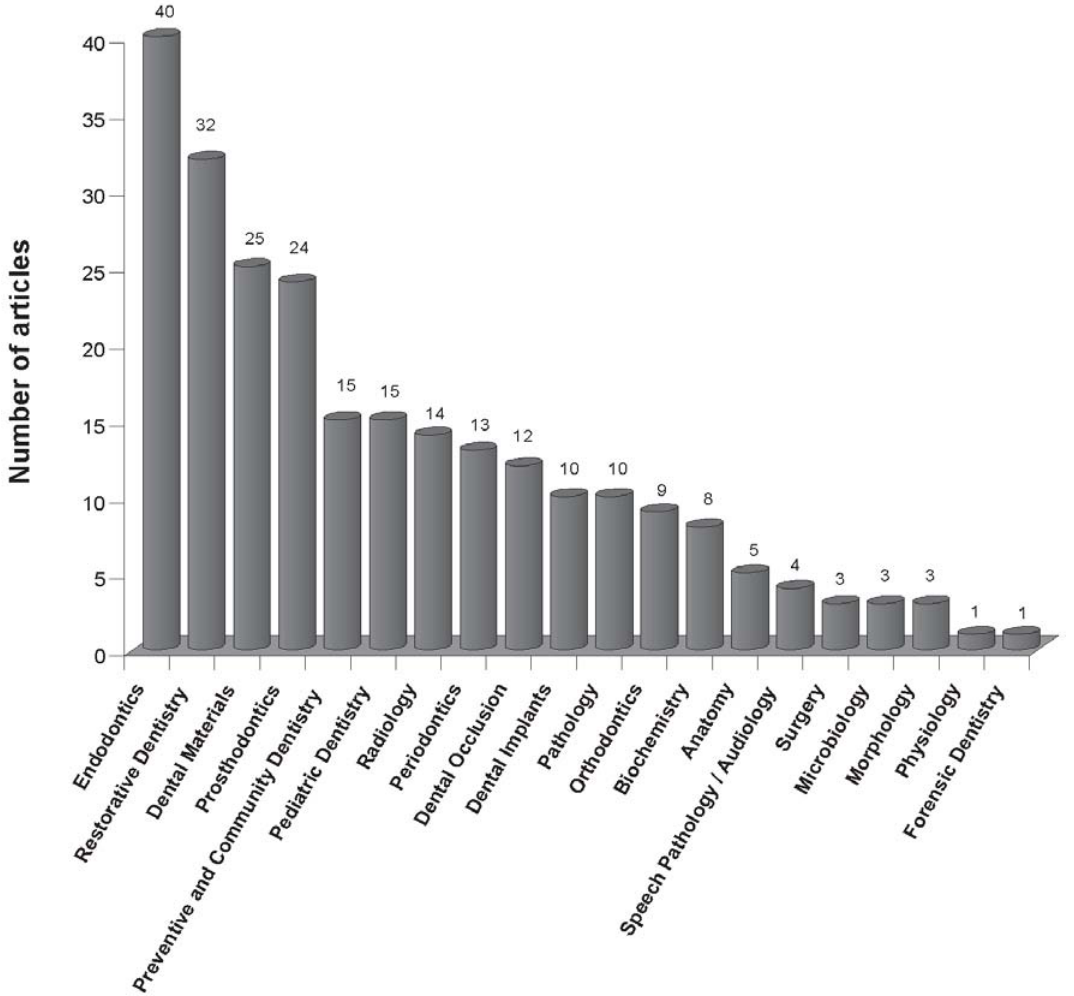
FIGURE 2- Number of articles published in the JAOS in each dental research field between 2005 and 2007